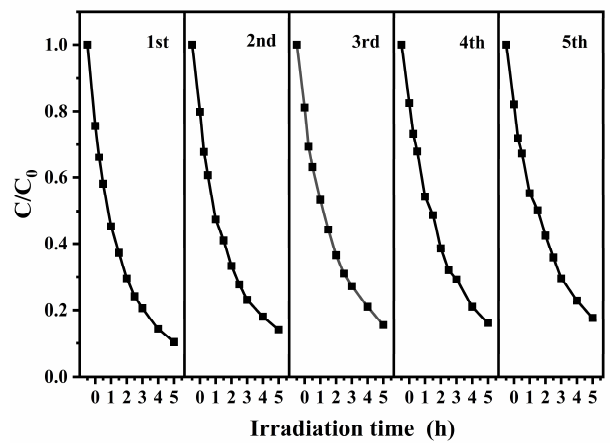
Figure 10. Photocatalytic activities of N-TiO 2 /SiC foam in five cycles of MB